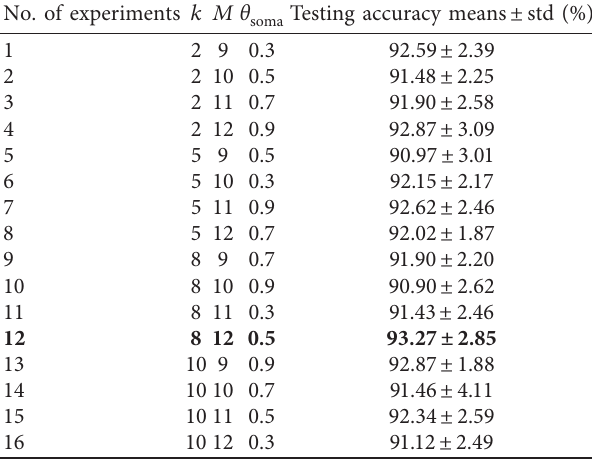
Table 6: L ( 4 3 ) orthogonal array and factor assignment of 16